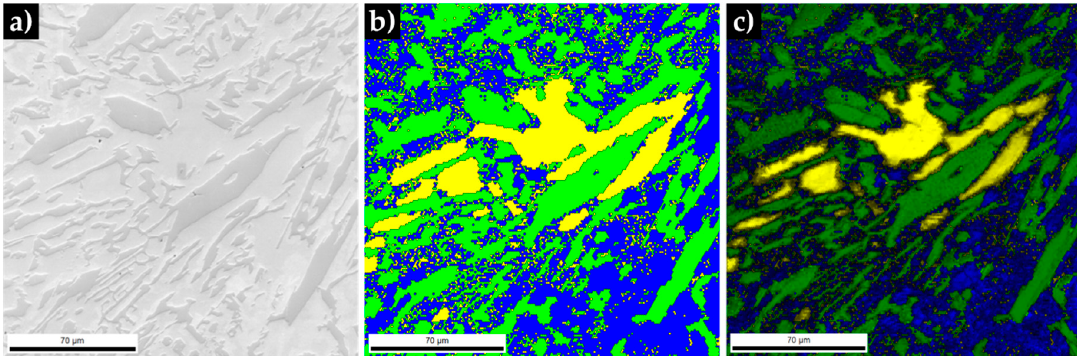
Figure 10. SEM image of the microstructure of the base metal ( a ), phase map: γ in yellow, α ’ in blue and M 7 C 3 in green ( b ) and image quality map ( c ).